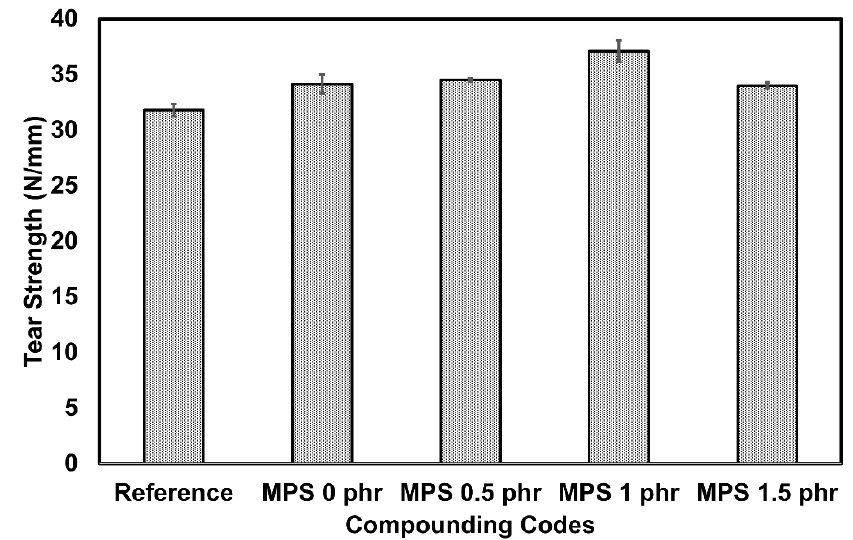
Figure 7. Tear strength of NR/HNT composites in the presence of MNR/MPS as dual compatibilizers.